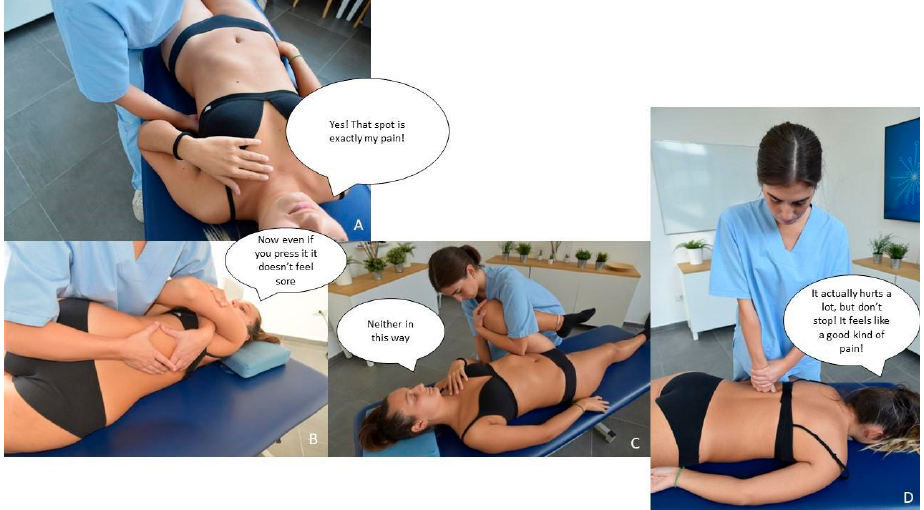
Figure A2. Clinical scenario 2. Clinical scenario n. 3 (Figure A3)